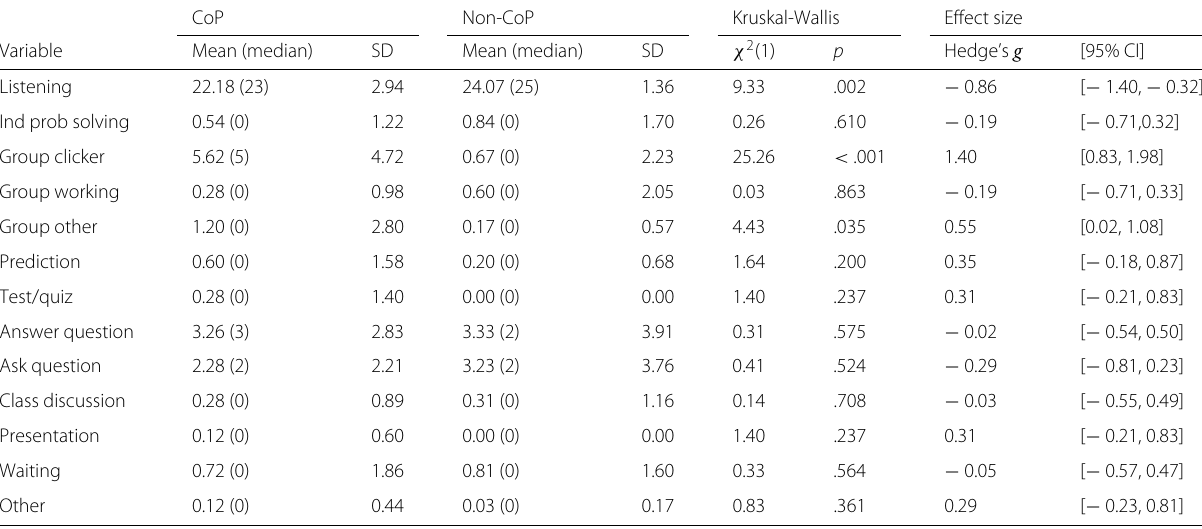
Table 4 Comparisons of central tendency and variation of the total counts of 2-min intervals where student behavior, as indicated by the original list of COPUS codes (from (Smith et al. 2013)), was observed by CoP ( n = 25) and non-CoP ( n = 35)